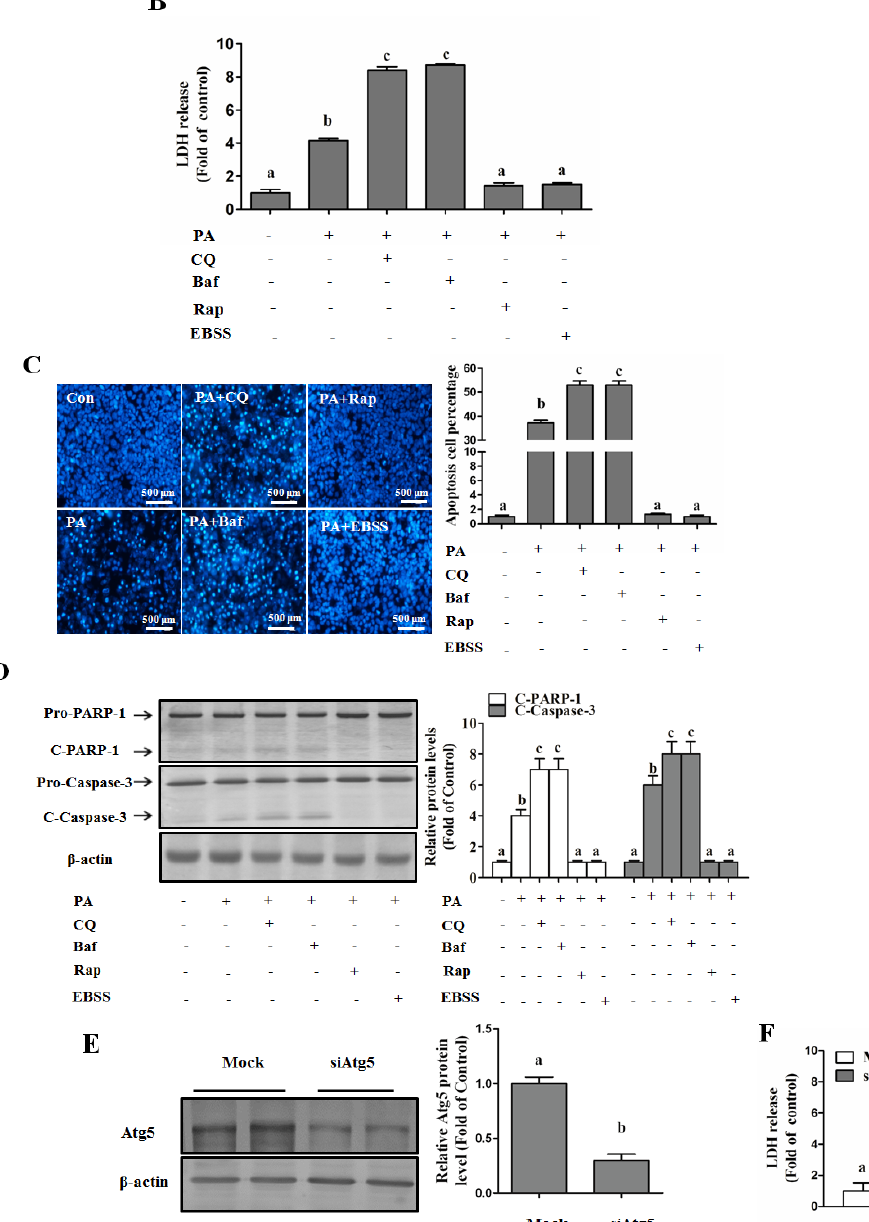
Figure 2. Regulating autophagy contributes to SFA ‐ induced lipotoxicity in hepatocytes. HepG2 cells were treated with palmitic acid (PA, 400 μ M) for 12 h with or without rapamycin (Rap, 1 μ M), Earle’s Balanced Salt Solution (EBSS), chloroquine (CQ, 20 μ M), or Bafilomycin A1 (Baf, 100 nM) pre ‐ treatment for 4 h. ( A ) Liver protein was extracted using RIPA lysis. Immunoblotting was performed for LC3; ( B ) LDH in the cultured medium was detected as described in the Methods; ( C ) Nuclear morphology was detected by Hoechst staining using fluorescence microscopy (magnification × 100); ( D ) Total lysates of HepG2 cells were subjected to immunoblotting assay for Caspase ‐ 3 and PARP ‐ 1; ( E ) Cells were transfected with either scrambled or Atg5 siRNA. Transfected efficiency was detected by immunoblotting assay; ( F ) After transfected with Atg5, cells were treated with palmitic acid (PA, 400 μ M) for 12 h. LDH in the cultured medium was detected as described in the Methods section. Each in vitro test was performed at least 3 times. Bars with different characters differ significantly ( p < 0.05).